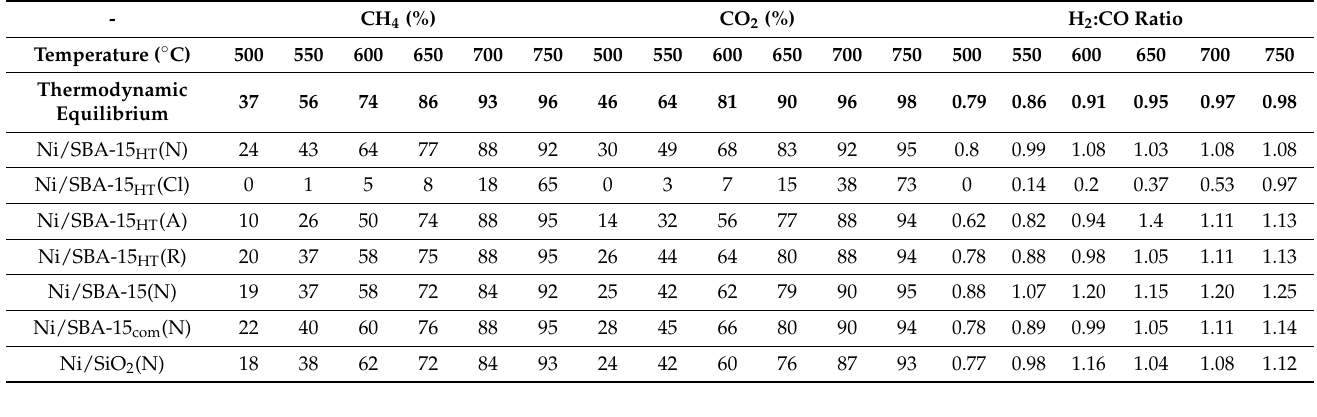
Table 2. Variation of CH 4 and CO 2 conversions and H 2 :CO molar ratio with temperature during the heat-up phase.